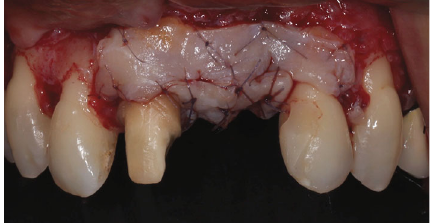
Figure 15: Sutured multilayered connective tissue graft (3 layers of occlusal connective tissue graft and one layer of buccal connective tissue graft).